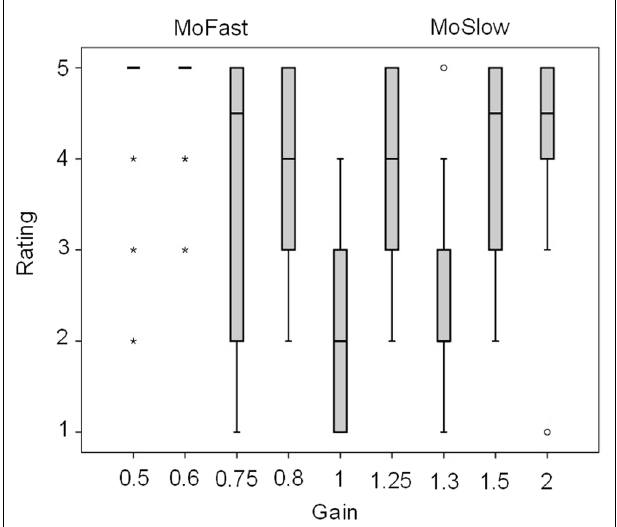
FIGURE 4 | Boxplots of the ratings of the presence of a transformation. Mild outlier, between 1.5 and 3 × interquartile range above the third or below the first quartile, *extreme outlier, more than 3 × interquartile range above the third or below the first quartile.Verbal coding for